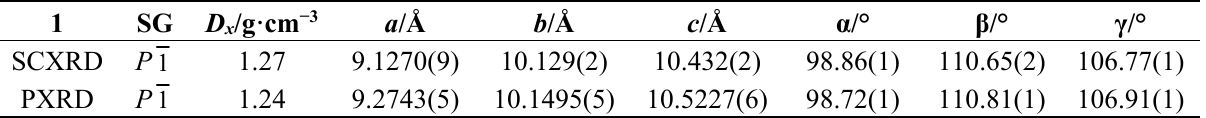
Table 3. Comparison of lattice parameters determined at 173 K (single crystal X-ray diffraction data, SCXRD) and 298 K (powder X-ray diffraction data).